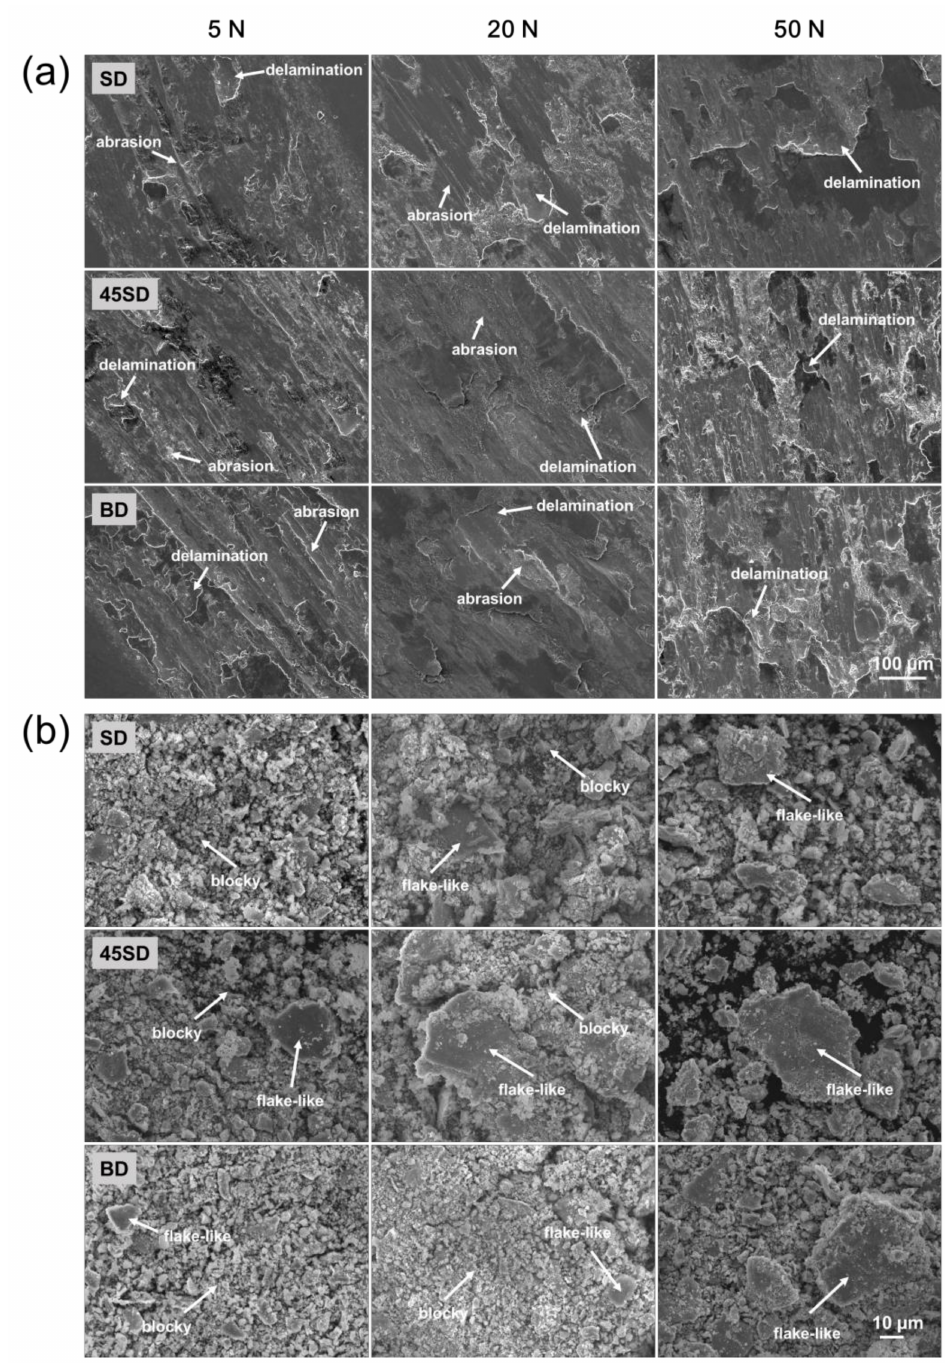
Figure 4. SEM images of ( a ) worn surface and ( b ) wear debris of as-built samples worn against AISI 52100 steel ball with different wear